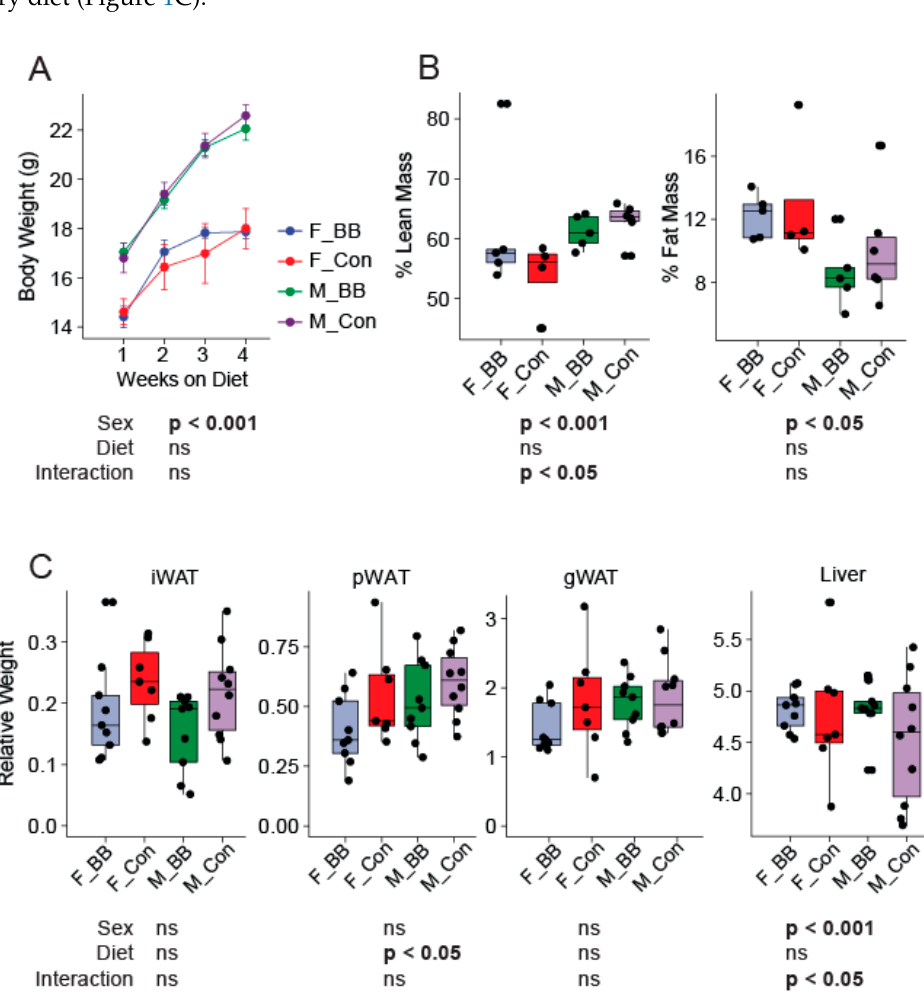
Figure 1. Body weight, body composition, and tissue weights of mice during the dietary intervention. ( A ) The body weight of male and female mice over the four weeks of dietary supplementation, ( B ) The body composition (% Lean mass and % Fat mass) at the end of the dietary intervention, and ( C ) iWAT (inguinal), pWAT (perirenal), gWAT (gonadal) white adipose tissue weights expressed relative to body weight at the time of euthanization. F-BB (female mice fed a blueberry diet) ( n = 9), F-Con (female mice fed a control diet) ( n = 7), M-BB (male mice fed a blueberry diet) ( n = 9), and M-Con (male mice fed a control diet) ( n = 10). A Two-Way ANOVA analysis was performed using R. Sex and diet and the interactions of both were used as two factors to determine the significance. (ns = non- significant).